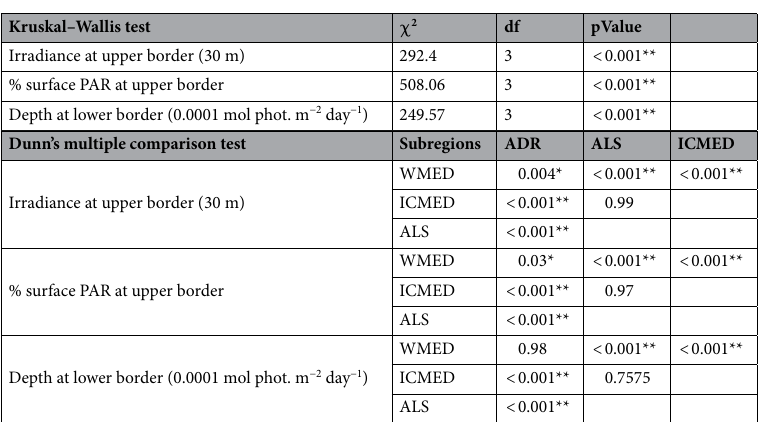
Table 1. Results of Kruskal–Wallis test and the post hoc Dunn’s multiple comparisons test, showing significance of differences in the irradiance and percent of surface PAR at the upper border, and in the depth of the lower mesophotic border among Mediterranean subregions. WMED Western Mediterranean Sea, ADR Adriatic Sea, ICMED Ionian Sea and central Mediterranean Sea, ALS Aegean-Levantine Sea. p value significance level; *p ≤ 0.05; **p ≤